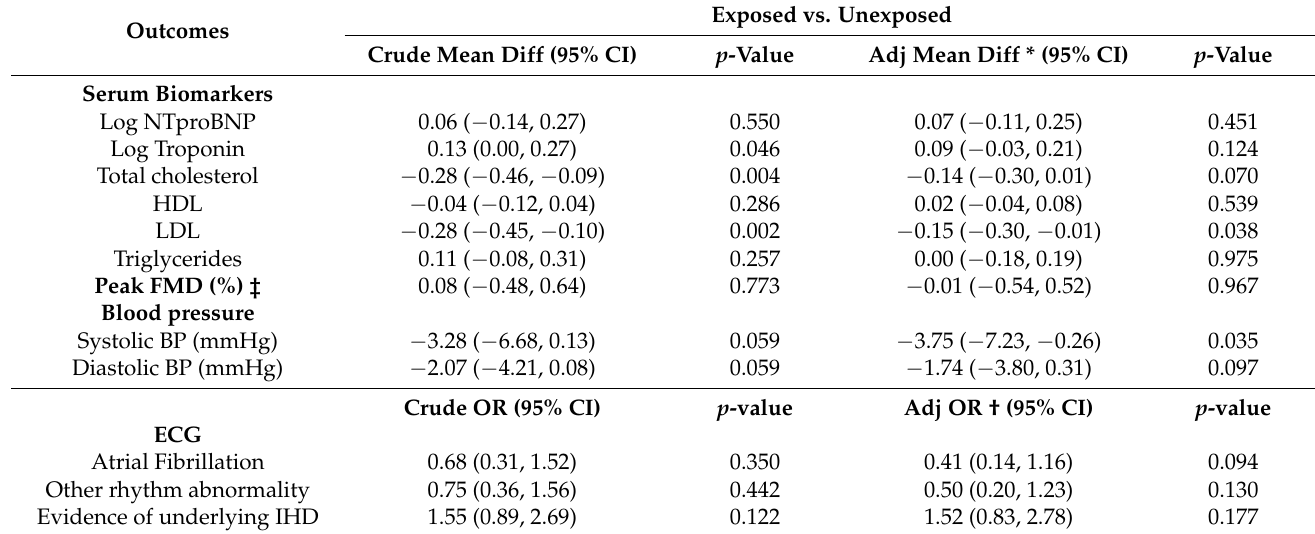
Table 5. Results of regression analysis for other cardiovascular outcomes (exposed vs